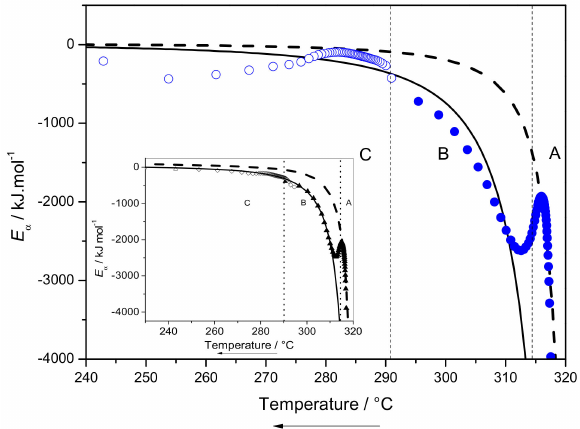
Figure 9. Fit of E α dependence vs. temperature for PTFE / SiO 2 (c)F and PTFE (inset) samples. Black triangles: PTFE; blue circles: PTFE / SiO 2 (c)F; open: Crystallization performed at the FSC cooling rates